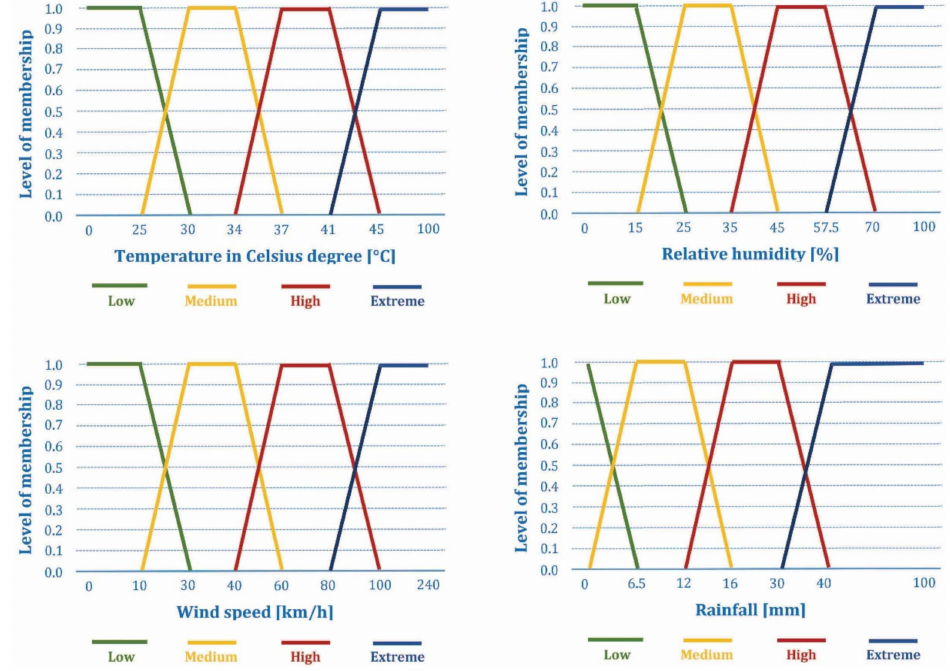
Figure 2. Membership functions of meteorological variables, adopted from